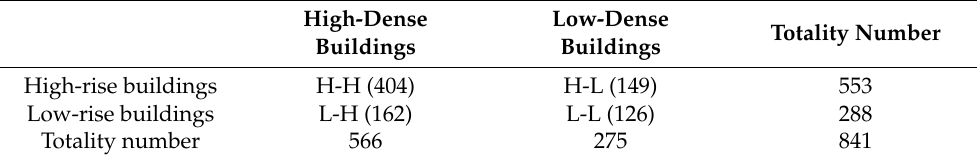
Table 6. Numbers of four typical communities.